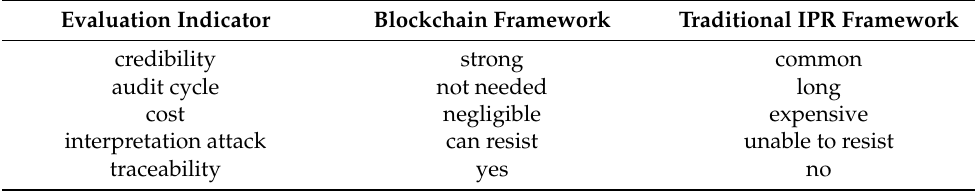
Table 6. Comparison between the blockchain and traditional